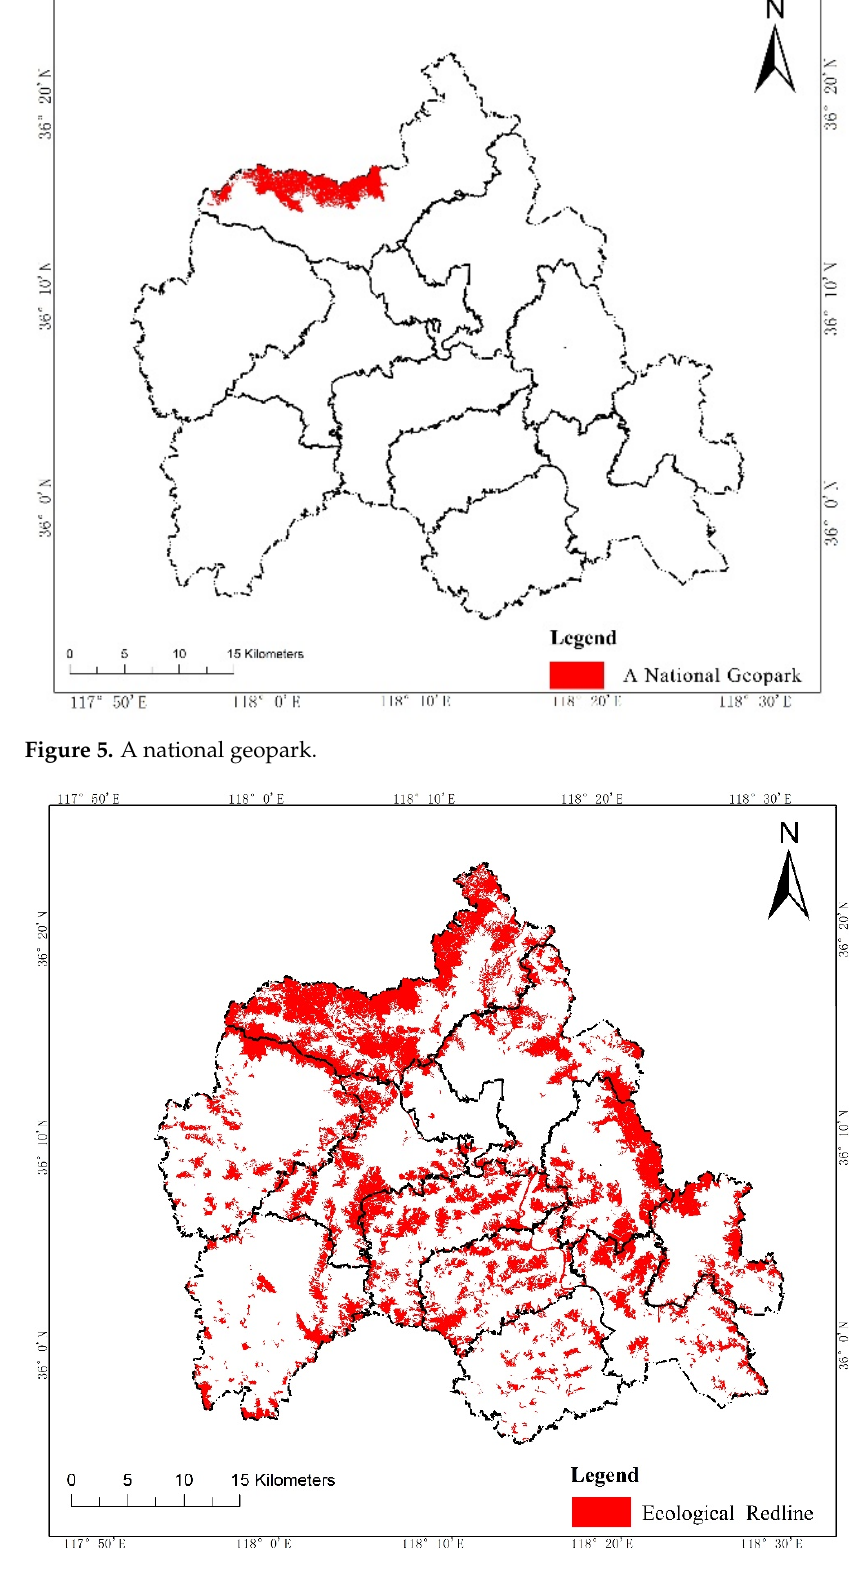
Figure 6. Ecological